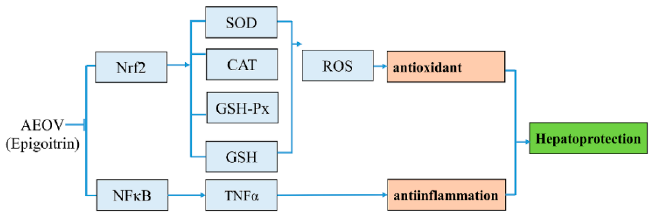
Figure 8. A schematic illustration of a proposed mechanism.